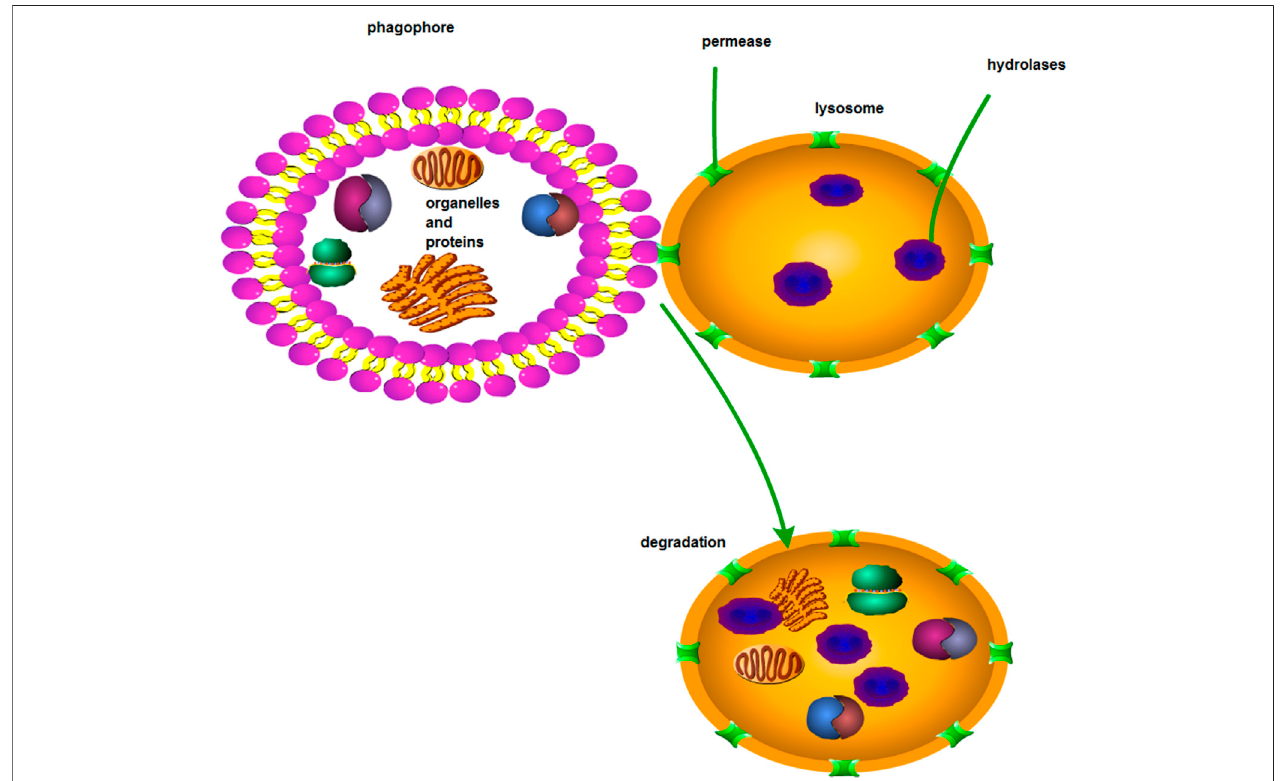
FIGURE 4 | Macroautophagy. Through macroautophagy, substances in solute are transported to lysosomes via the autophagosome of a bilayer lipid.